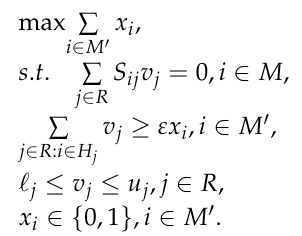
Figure S1: Cellobiose Media (a) Metabolic Process (b) Secondary Metabolites Process, Figure S2: Avicel Media (a) Metabolic Process (b) Secondary Metabolites Process, Table S1: Cellobiose Media Metabolites Annotation, Table S2: Avicel Media Metabolites Annotation, Table S3: Raw metabolomics data for growth on cellobiose and